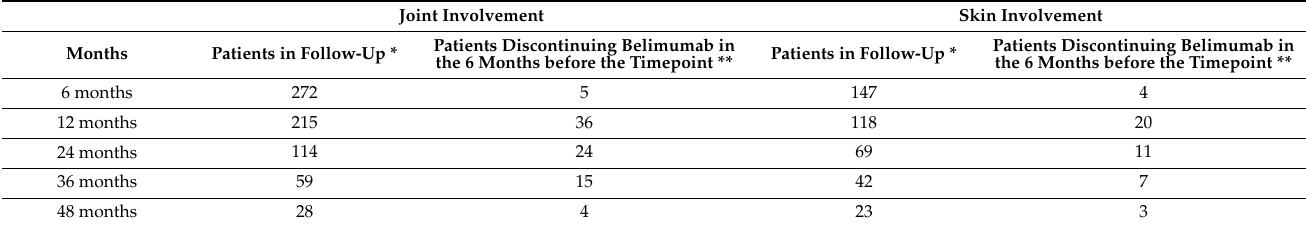
Table 2. Number of SLE patients with joint or skin involvement considered in the analyses at different timepoints, including those in follow-up and those who discontinued the drug due to inefficacy in the 6 months before achieving the